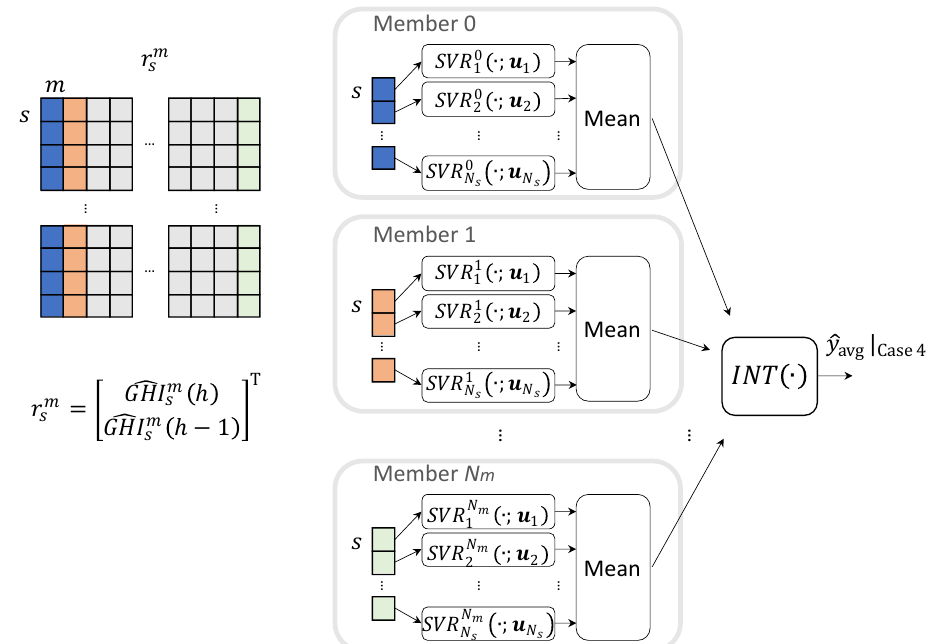
Figure 6. Schematic of the access of the MEPS’s GHI forecasts in Case4. This prediction model places the integrator ( INT ( • ) ) at the last layer. Weak learners ( SVR m s ( • , u s ) ) output are gathered into the mean function for each MEPS ensemble member to obtain the regional GHI ensemble prediction, and then their forecasts enter the ensemble node.